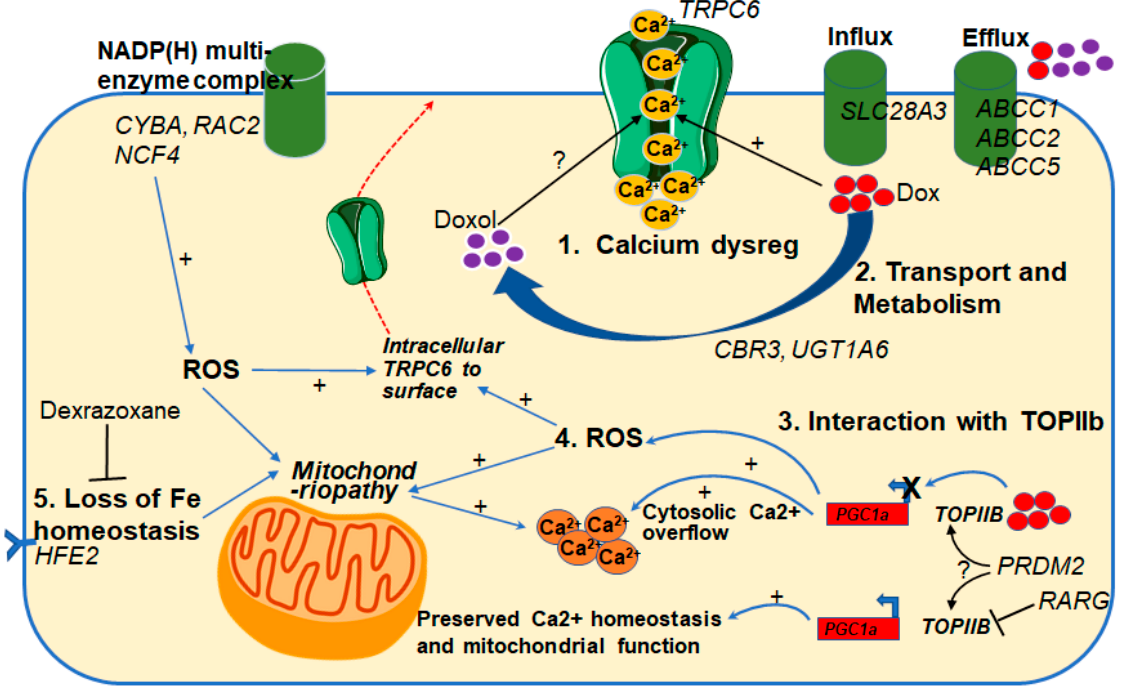
Figure 1. Multiple putative risk genes and pathways of anthracycline-related cardiotoxicity. Putative risk genes are shown in uppercase italics within their proposed pathway of cardiotoxicity: (1) Calcium dysregulation; (2) Transport and metabolism; (3) Interaction with TOP2B; (4) Generation of Reactive Oxygen Species (ROS); (5) Iron homeostasis. Arrows mark pathways and potential interaction between pathways of cardiotoxicity. For example, generation of ROS and loss of iron homeostasis results in mitochondriopathy and cytosolic calcium overflow, but interaction of anthracycline with TOP2B also results in down-regulation of PGC1a and subsequent cytosolic calcium overflow. Increased TRPC6 expression or activity is influenced by genetic variants and results in increased calcium influx, but doxorubicin alone may also increase TRPC6 activity. Genetic variants in anthracycline transport and metabolism-related genes will affect the level of intracellular anthracyclines and their different metabolites and potentially increase (+) or decrease TRPC6 activation. ?, effect of metabolite or variant not known.